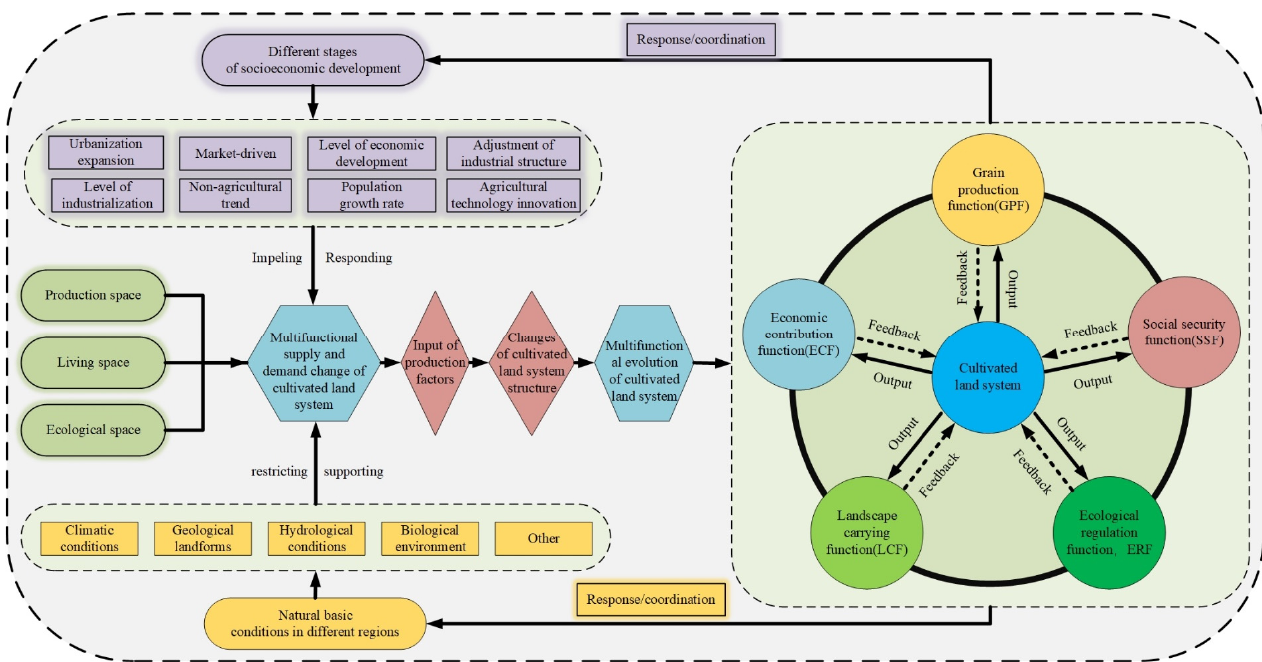
Figure 1. Multifunctional evaluation framework of cultivated land (GESEL).